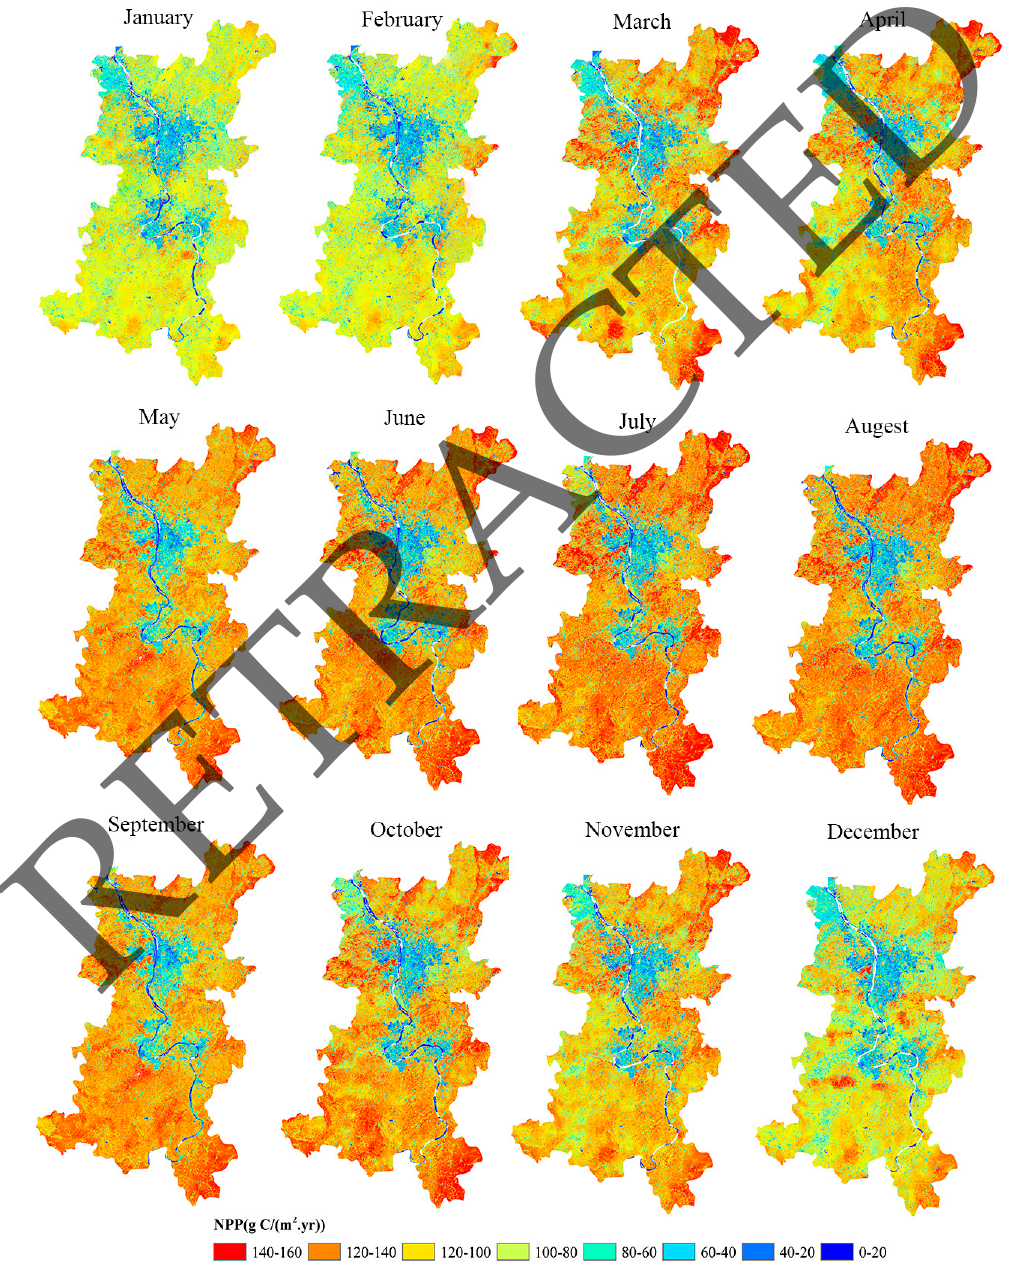
Figure 12. Monthly time series NPP of the Changsha–Zhuzhou–Xiangtan area in 2015, estimated based on the fused NDVI.